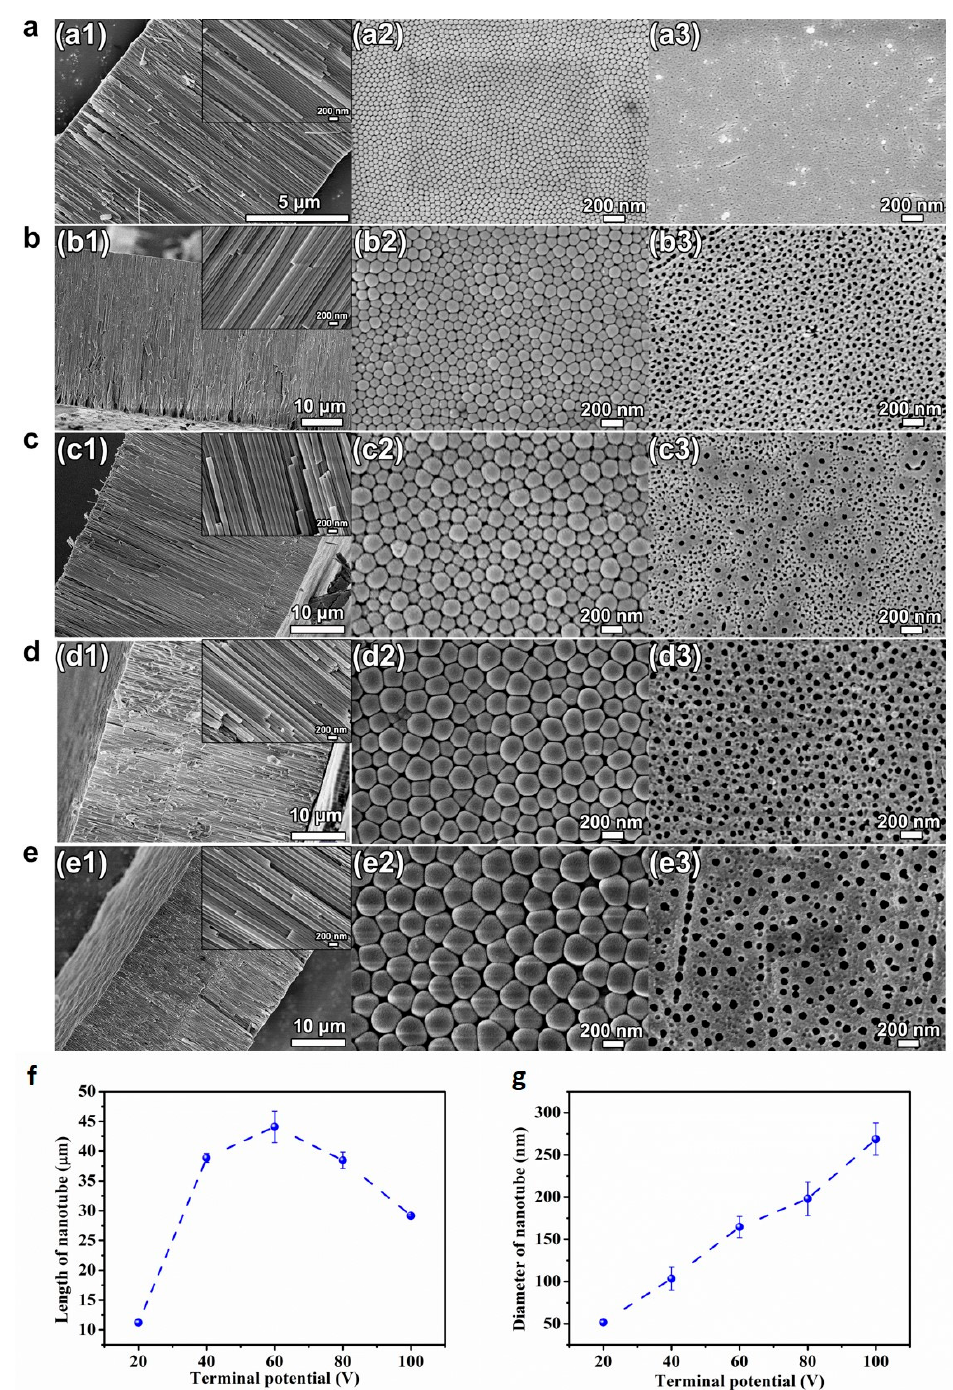
Figure 1. ( a – e ) SEM images of cross-sectional ( a1 – e1 ), bottom ( a2 – e2 ) and top view ( a3 – e3 ) of the HEO nanotube arrays formed under various potentials: ( a ) 20 V, ( b ) 40 V, ( c ) 60 V, ( d ) 80 V and ( e ) 100 V after anodization for 4 h in the ethylene glycol solution containing 0.1 mol/L NH 4 F and 10 vol.% of water; ( f ) The changes in nanotube length and diameter ( g ) with applied potential. The thickness of the oxide layers formed at different potentials is plotted in Figure 1f. The length of the nanotube increases with potential from 20–60 V but decreases from 60–100 V. The increase of the length results from the increased growth rate since the higher voltage leads to a higher steady state current density. However, at high voltages (>60 V), the trend is opposite. The decrease of the layer thickness at high anodization voltage (80 and 100 V) might be attributed to the electro-polishing, which results in the collapse of